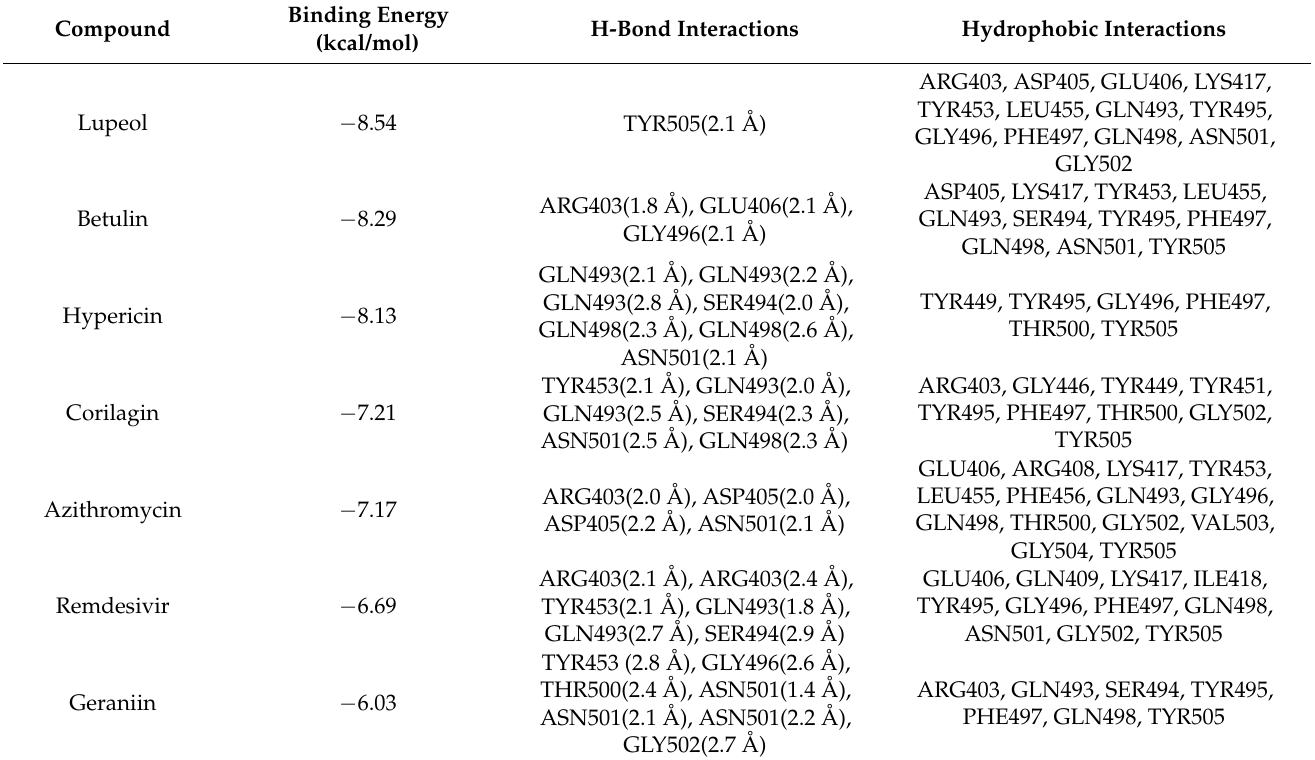
Figure 6. 3D diagram of S RBD of wild-type SARS-CoV-2 in complex with ( A ) Betulin, ( B ) Hypericin, ( C ) Corilagin, ( D ) Geraniin, ( E ) Remdesivir, and ( F ) Azithromycin. The interacting amino acid residues and the ligand molecules in the protein-ligand complexes are illustrated as blue and green sticks, respectively. The yellow dashed line represents the hydrogen bond in the protein-ligand complex. Table 1. Molecular docking results of potential compounds against wild-type S